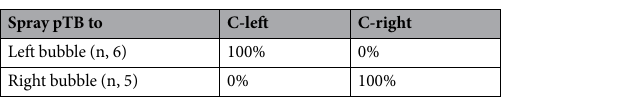
Table 1. The orientation of the incorporated pTB channel after one-bubble